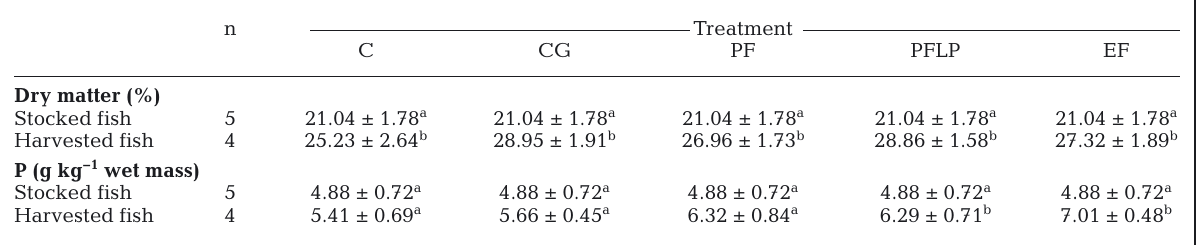
Table 4. Chemical composition (mean ± SD) of carp Cyprinus carpio at stocking and harvesting. Treatments as in Fig. 1. Super- scripts a and b represent outcomes from the non-parametric Mann−Whitney U -test between stocked and harvested fish. Mean values in the same column with different superscripts differ significantly (p < 0.05)